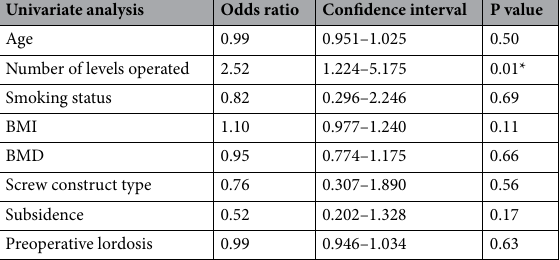
Table 5. Logistic regression analysis demonstrating factors associated with nonunion. BMI body mass index, BMD bone mineral density; *P < 0.05.